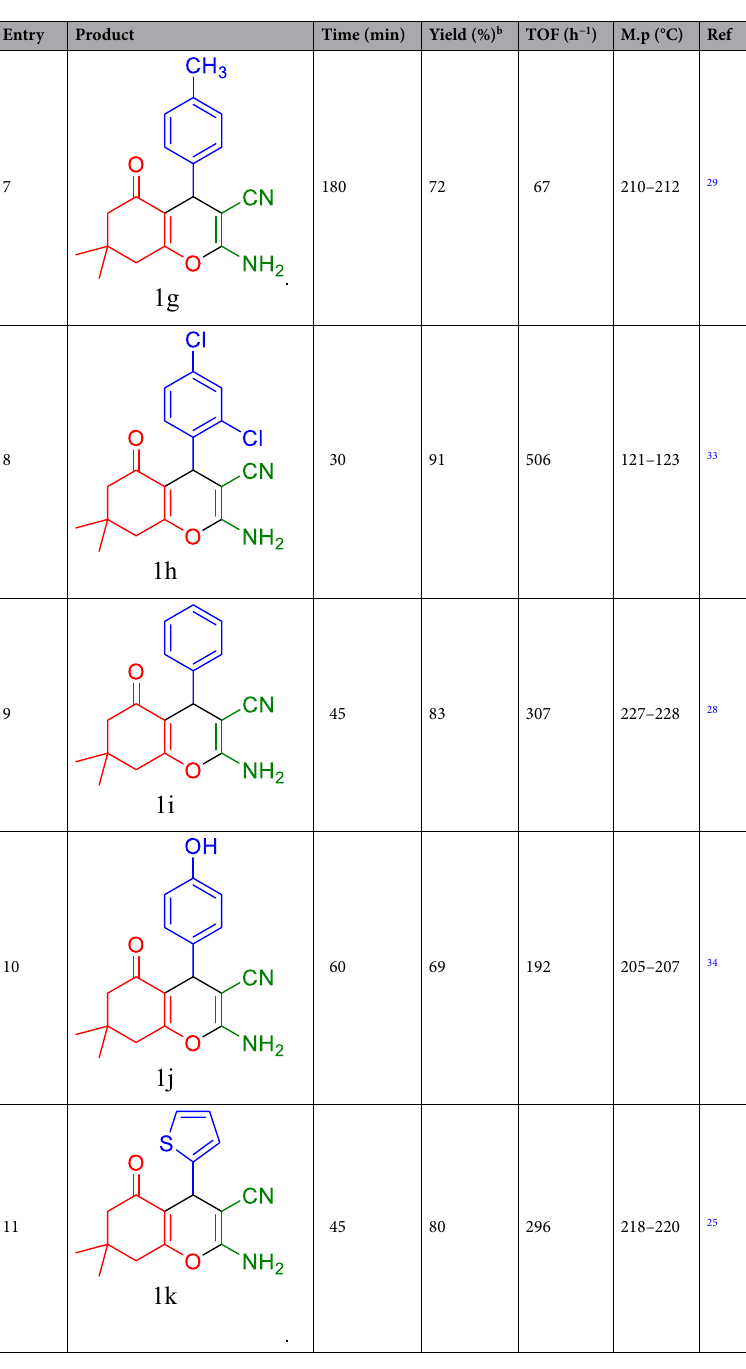
Table 4. One-pot synthesis of tetrahydrobenzo[b]pyran with aldehyde, malononitrile and dimedone catalyzed by HMS/Pr-Xa-Ni a . a Aldehyde (1 mmol), malononitrile (1 mmol), dimedone (1 mmol), HMS/Pr-Xa-Ni